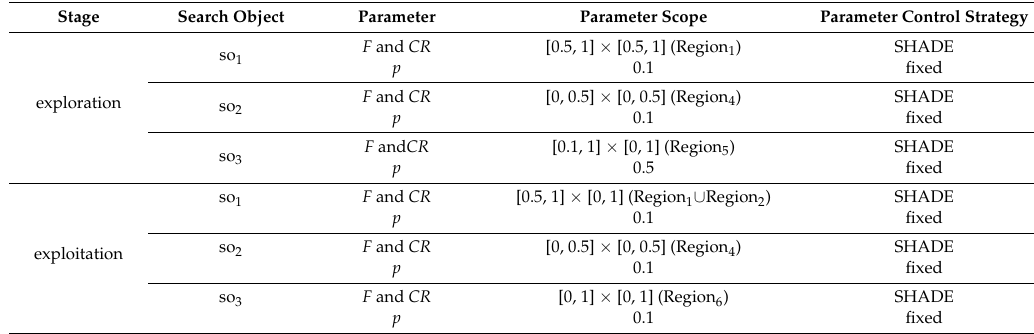
Table 2. Parameter scheme of PVCDE.